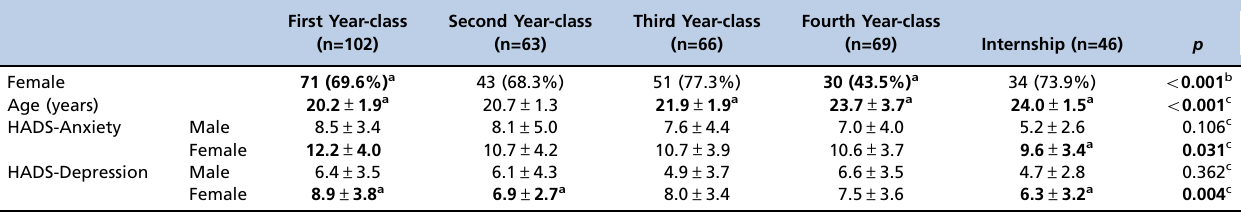
Table 1 - Analysis of HADS-Anxiety and HADS-Depression and with whom spend the quarantine in each year-class (n=347).